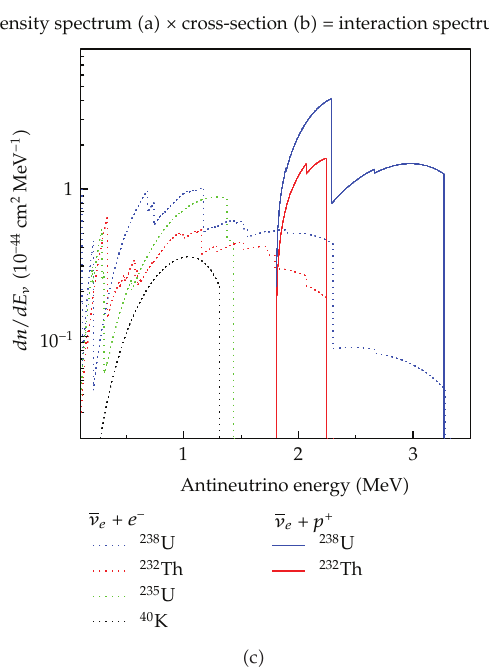
Figure 5: (cid:5) a (cid:6) Antineutrino intensity energy spectra. The area below each curve equals the number of antineutrinos n ν emitted per decay. (cid:5) b (cid:6) Total cross-sections for scattering of antineutrinos on protons and electrons. (cid:5) c (cid:6) Antineutrino interaction energy spectra per decay of parent nuclide. Solid lines in (cid:5) b (cid:6) and (cid:5) c (cid:6) show antineutrino scattering on protons; dashed lines show scattering on electrons. Adapted from (cid:3) 39 (cid:4) , reproduced/modified by permission of American Geophysical